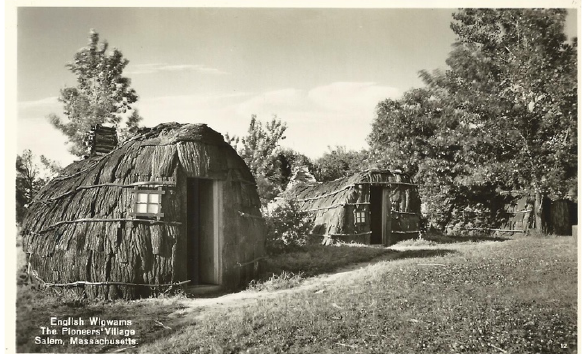
Figure 4. English wigwams at the Pioneers' Village (Source: